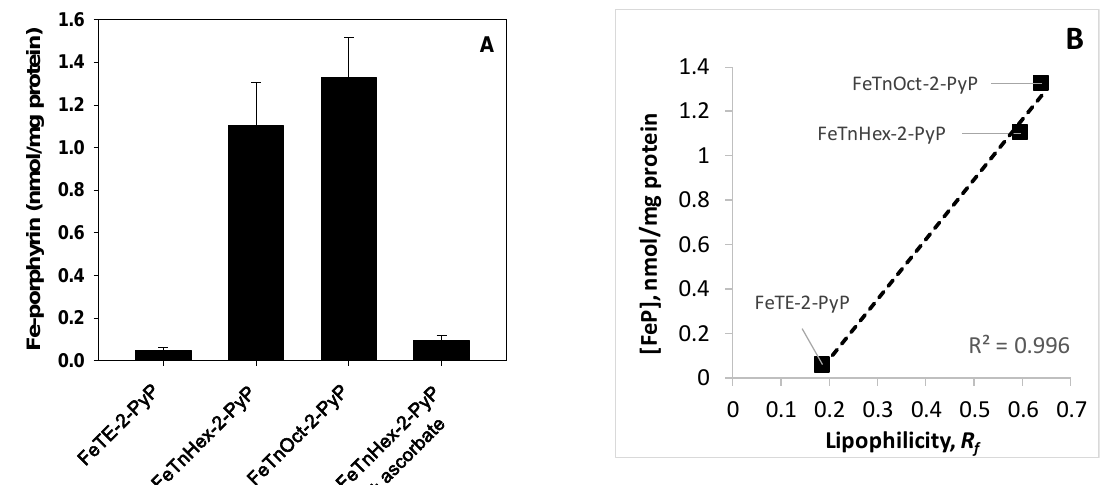
Figure 6. Cellular uptake of FePs. ( A ) E. coli was treated with FePs alone or in combination with ascorbate. E coli suspensions in PBS-glucose were incubated for one hour with 5 μM FePs on a thermostatic shaker at 37 °C and 200 rpm. Where indicated, ascorbate was added to 1.0 mM. At the completion of the incubation period, cells were thoroughly washed, resuspended in deionized H 2 O and disrupted by French pressing. Homogenates were cleared from debris by centrifugation and cell-free extracts were used for spectrophotometric assessment of FeP content. The results show mean ± SD. ( B ) Correlation between the lipophilicity (Rf data taken from [24]) and cellular uptake of cationic FePs.